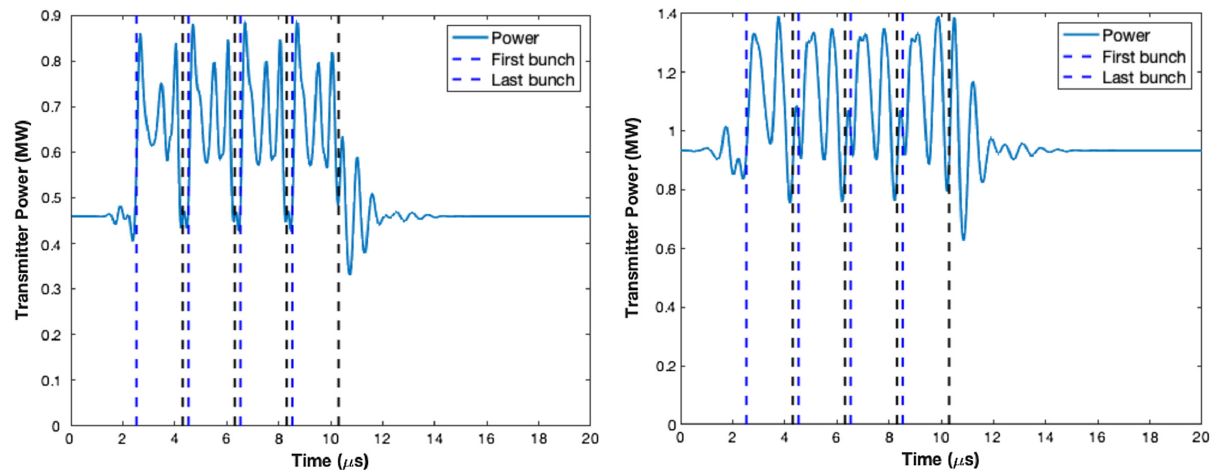
FIG. 24. Transmitter power with proposed design. First and last bunch for each batch are indicated with vertical dashed lines. Left: three-section cavity. Right: four-section